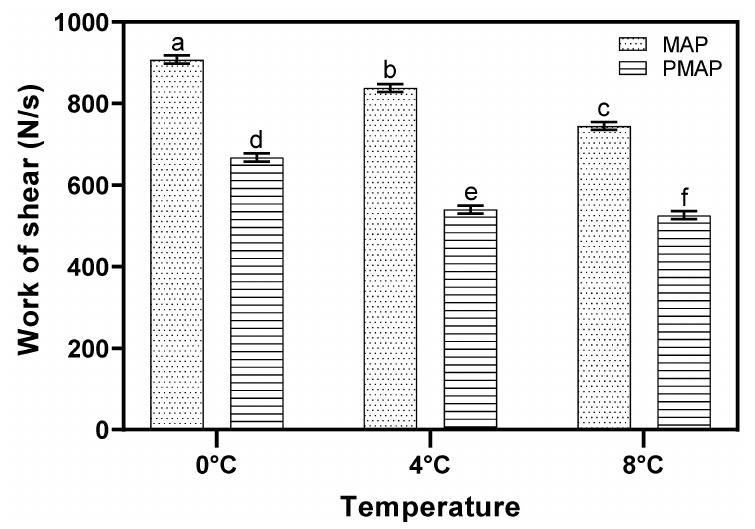
Figure 5. Effect of temperature and packaging on firmness (work of shear (N/s)) on day 3 with absorbent pads. Different letters indicate a significant difference in work of shear values ( p < 0.001). MAP = active-MAP and PMAP =